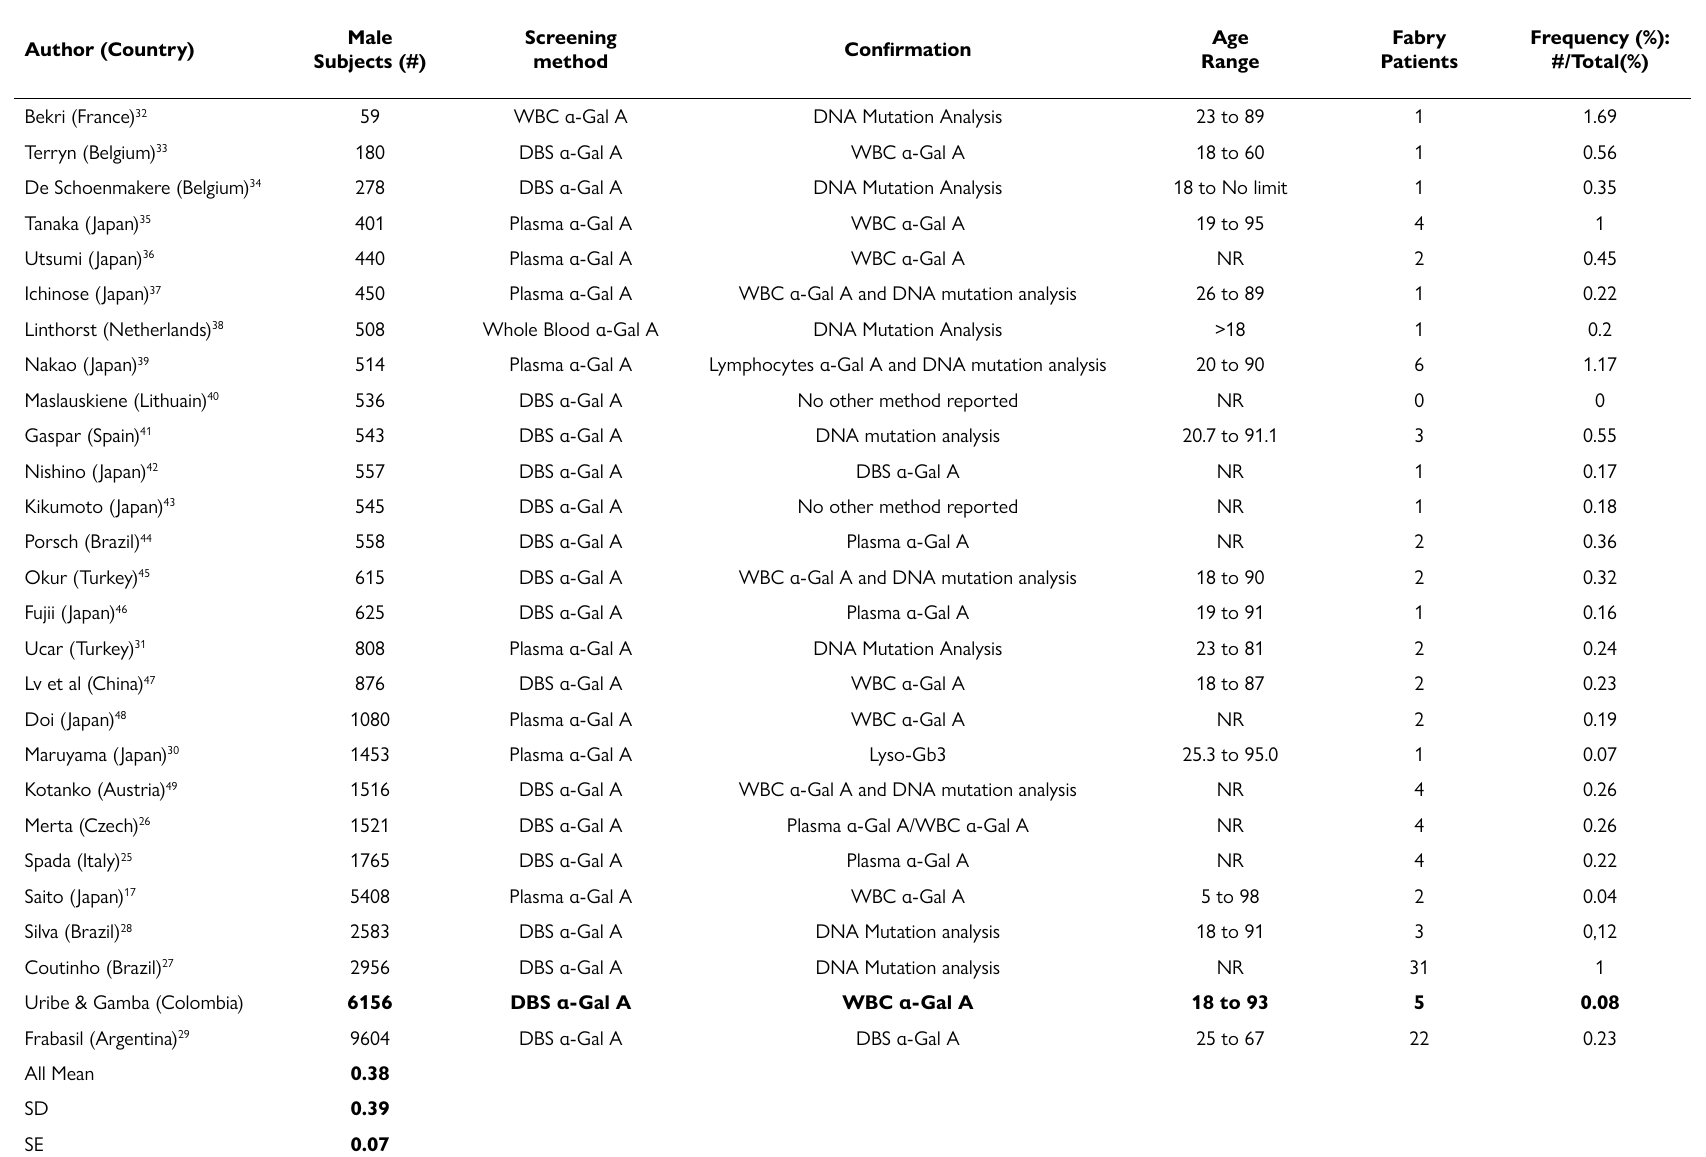
Table 2. Comparative values for Fabry in males with ESRD on similar